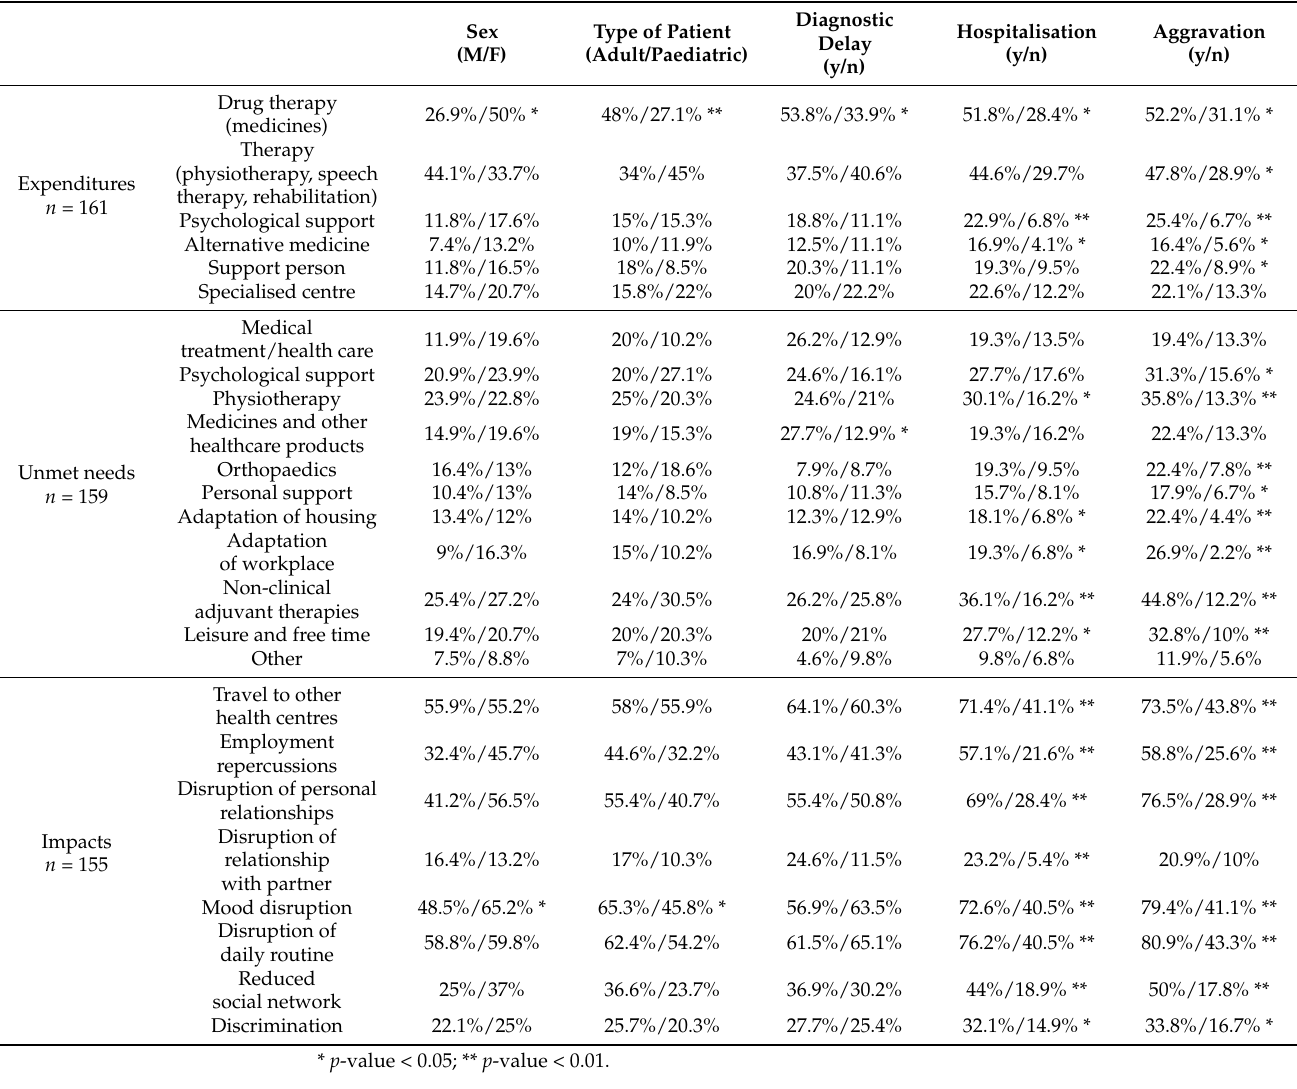
Table 3. Expenditures, unmet needs, and impacts secondary to the rare disease.